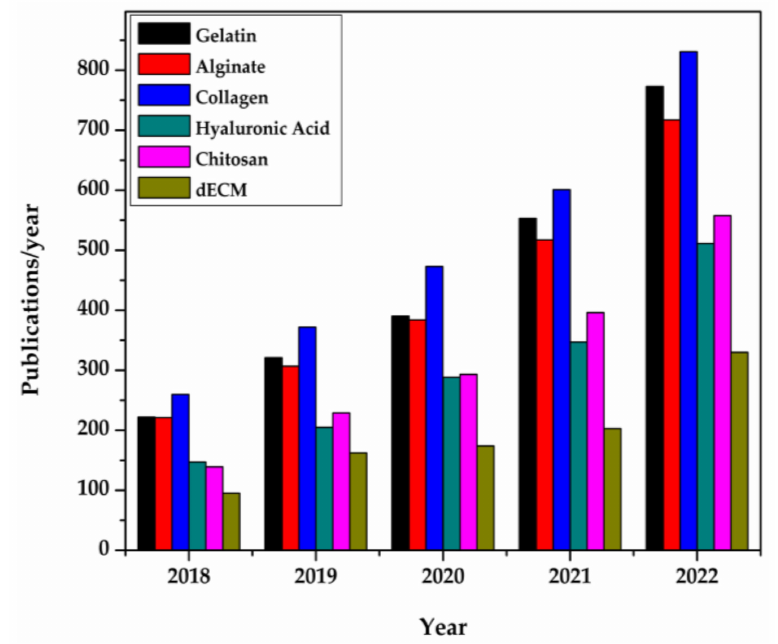
Figure 3. Natural polymer publication/year in 3D bio-printing for tissue engineering [101]. The bars represent the number of publications retrieved from Science Direct. The examined time interval was 2018–2022.